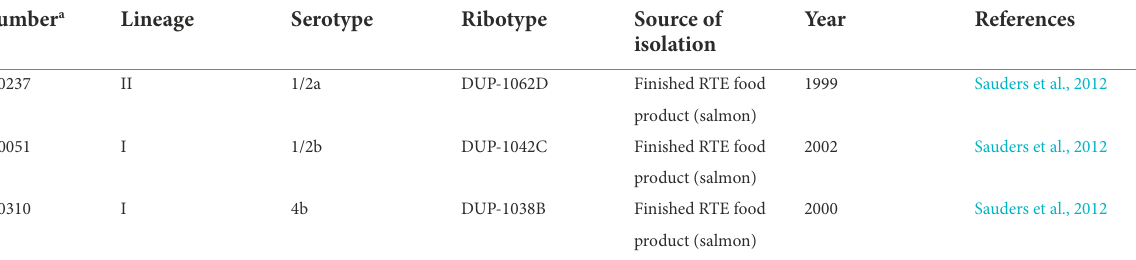
TABLE 1 Listeria monocytogenes strains used in this study. FSL number a